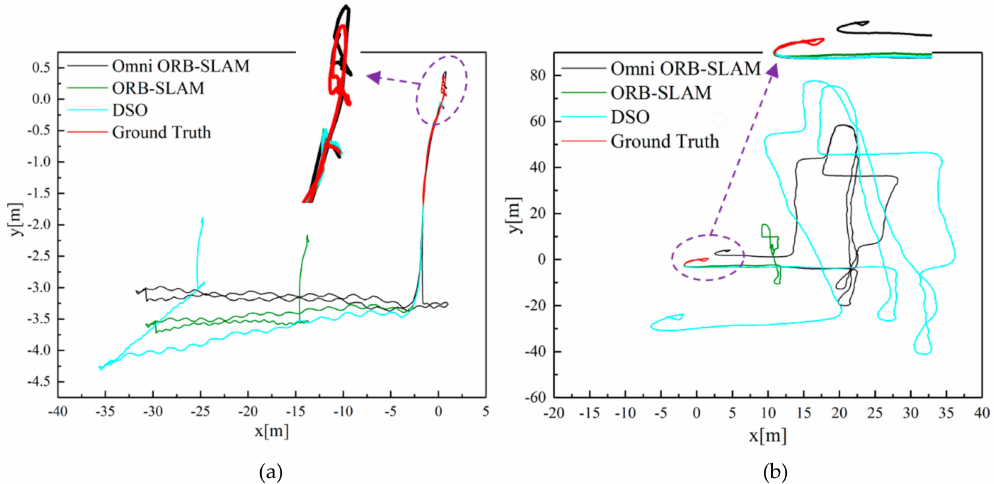
Figure 7. Estimated trajectories. The ground truth is available for the start and end segments in the same room. Dataset: ( a ) corridor4; ( b ) magistrale2.